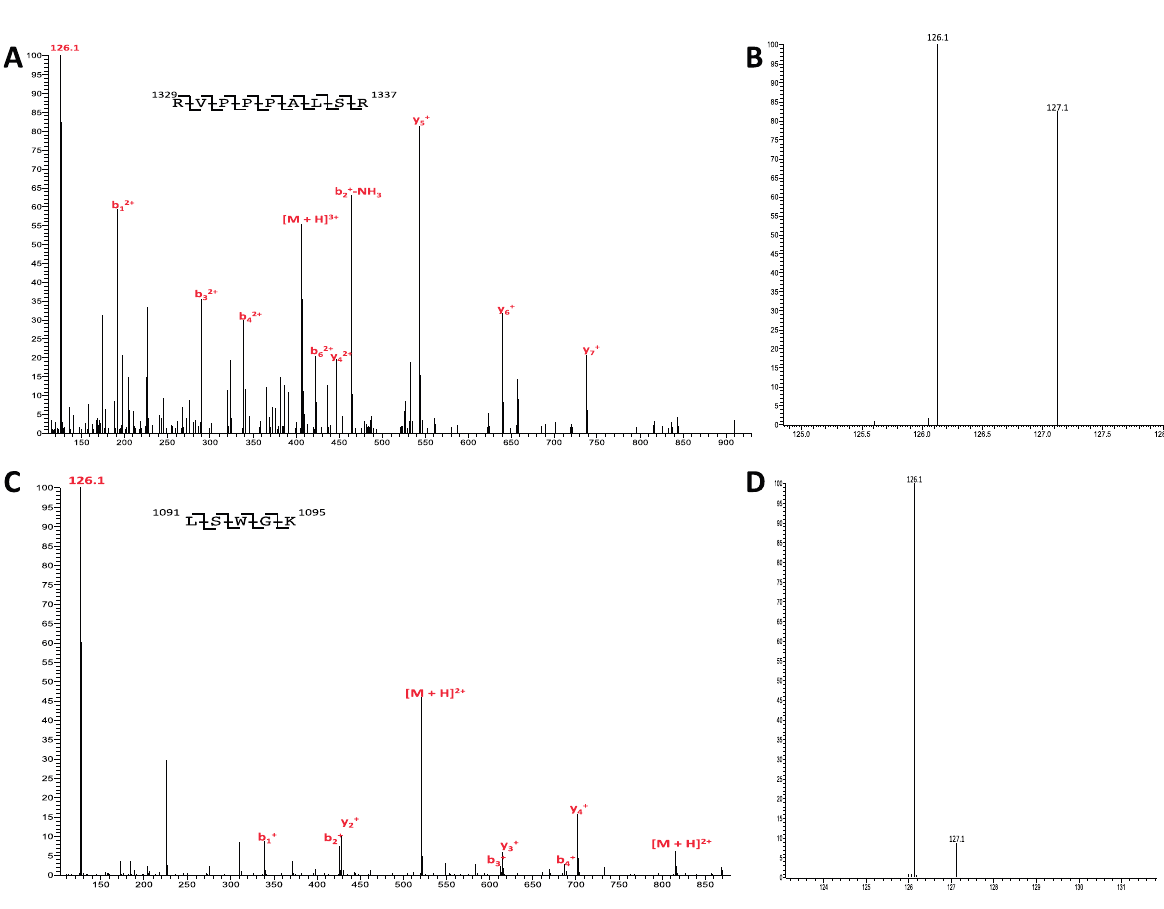
Figure 3. Quantification of phosphorylation on eIF4G. ( A ) MS/MS spectra of m / z ion 992.6, z = 2. Peptide spans residues 1072–1085; ( B ) Zoomed in view of the m / z region containing the TMT reporter ions. Calculation of the reporter ion ratio reveals a phosphorylation level of 15% for Ser-1077; ( C ) MS/MS spectra of m / z ion 520.8, z = 2. Peptide spans residues 1091–1095; and ( D ) Zoomed in view of the m / z region containing the TMT reporter ions. Calculation of the reporter ion ratio reveals a phosphorylation level of 40% for